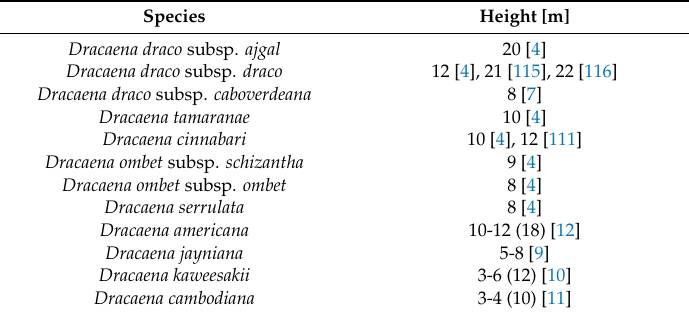
Table 2. Height of the individual species of the dragon